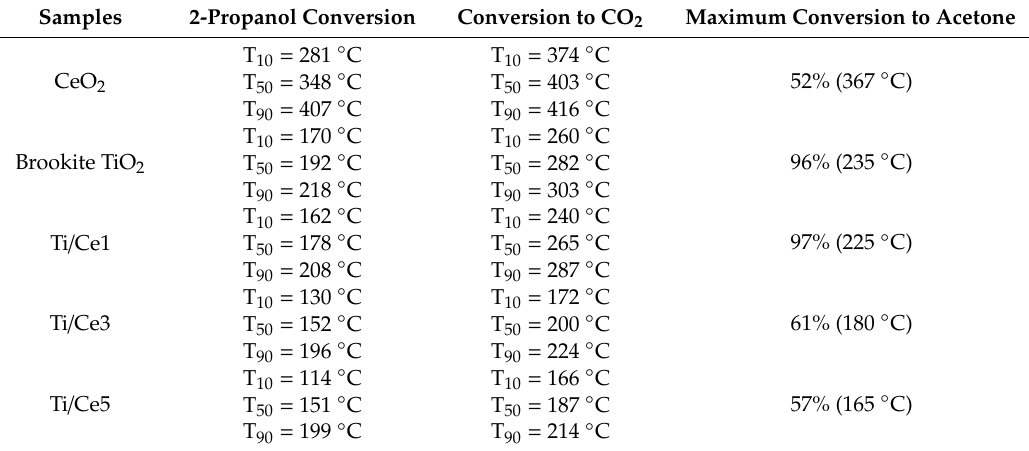
Table 4. The photo-thermocatalytic oxidation of 2-propanol over the investigated samples. Samples 2-Propanol Conversion Conversion to CO